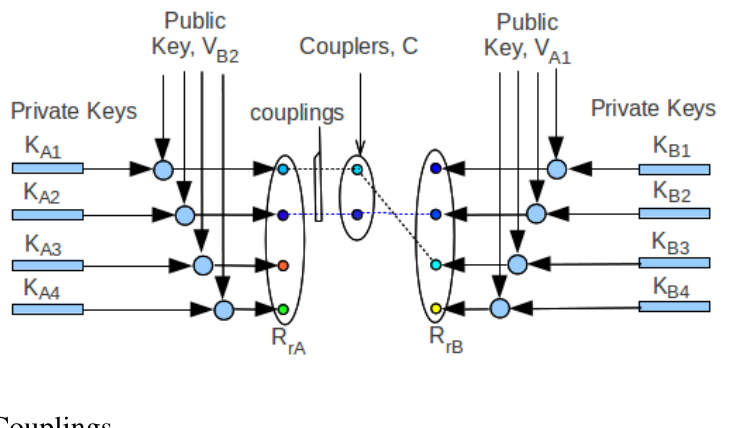
Figure 3. Pairing attack having unique couplers, for the case N = 2 , η = 2